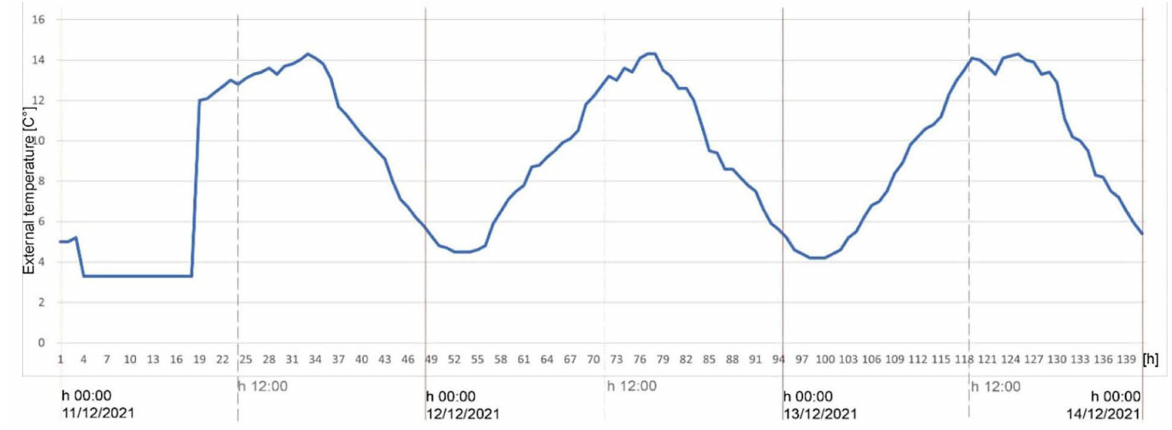
Figure 17. External temperature diagram as a function of time: post operam.